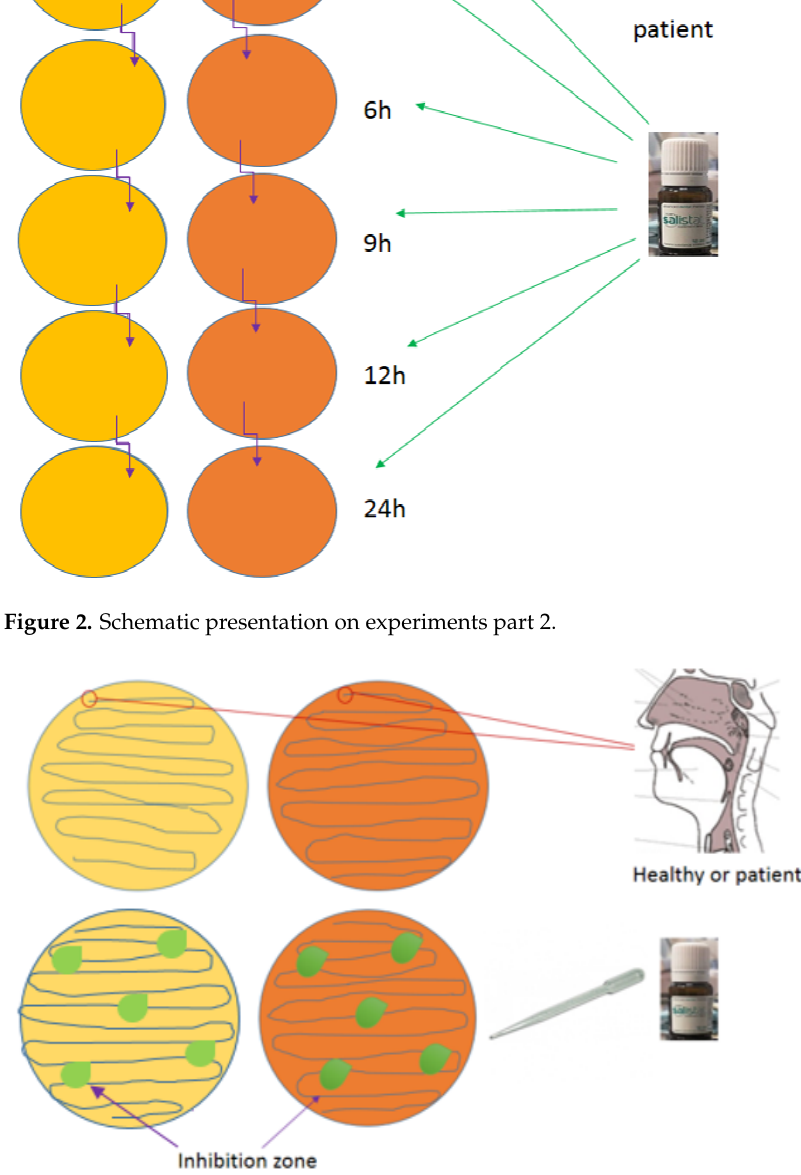
Figure 3. Schematic presentation on experiments part 1